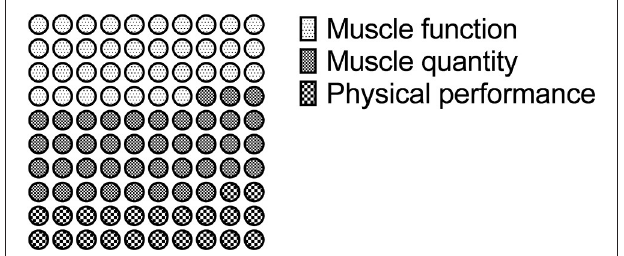
FIGURE 2 | Schematic representation of frequency of outcome examined ( n = 54) within the 32 included studies concerning HIIT and phenotypic characteristics of